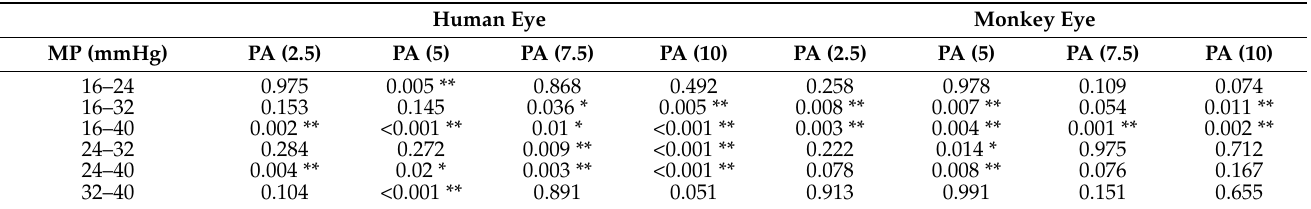
Table 1. p -value for TM recoil time constant over different mean pressures and pulse amplitudes. Human Eye Monkey